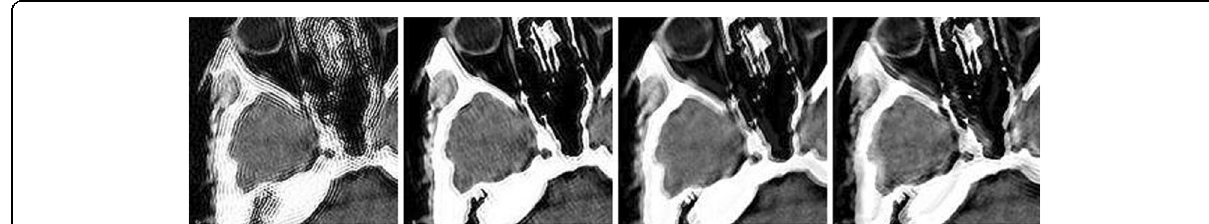
Fig. 9 Comparison of reconstructed images of local details amplification with different reconstruction methods (head